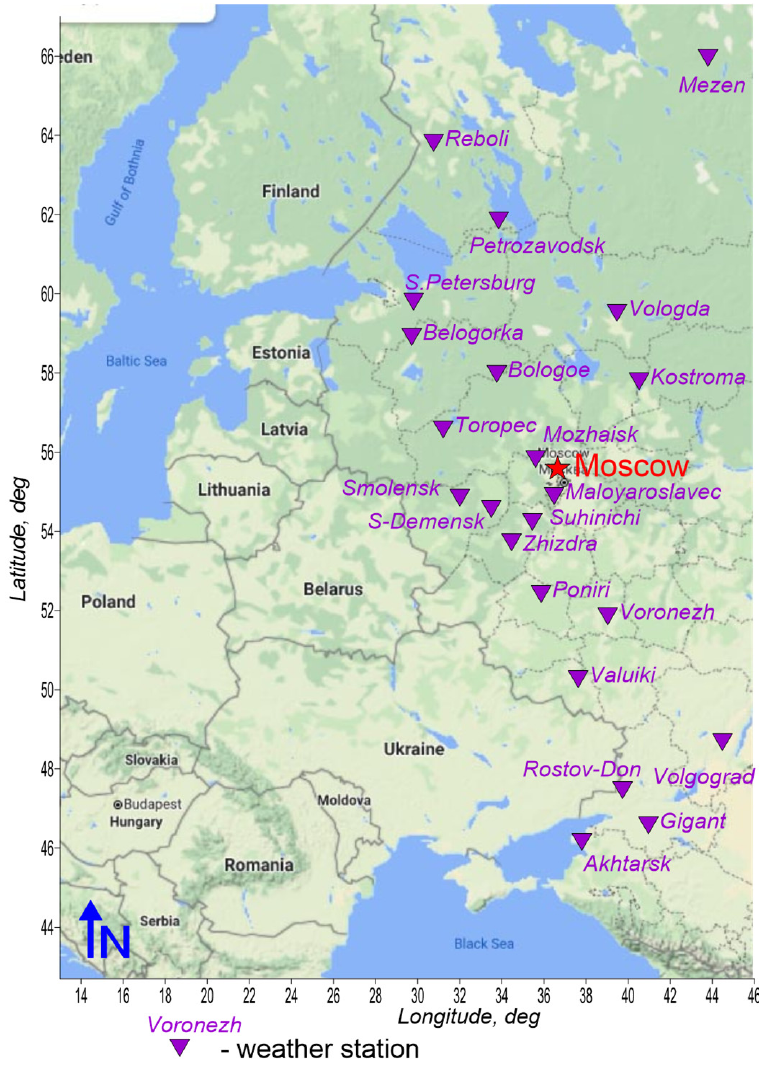
Figure 1. The study area of the European part of Russia and the location of the weather stations used.